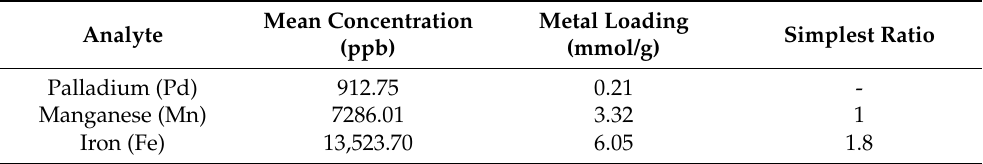
Table 1. ICP-MS results for Pd-Chit@MnFe 2 O 4 . *1.0 mg Pd-Chit@MnFe 2 O 4 was dissolved in 3 mL aqua regia and top-up with water to a total volume of 25 mL.